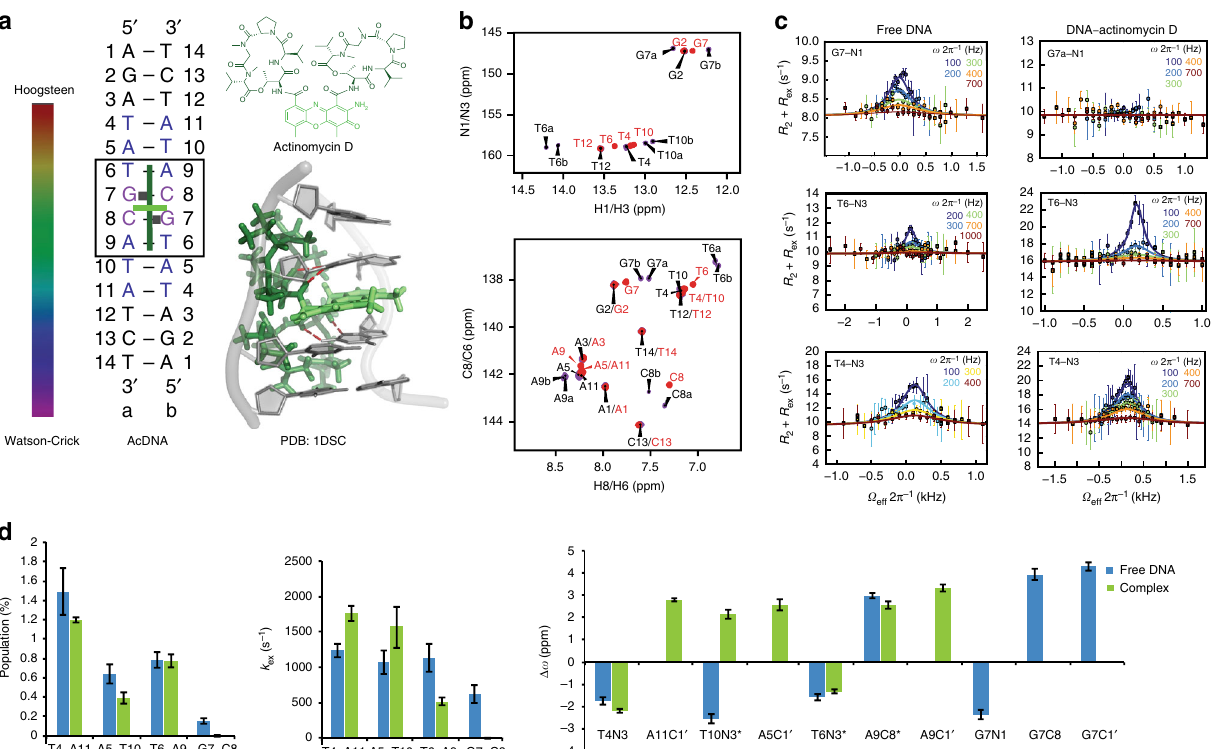
Fig. 5 Hoogsteen breathing in the DNA – actinomycin D complex. a Chemical structure of actinomycin D, crystal structure of the DNA – actinomycin D complex (PDBID 1DSC), and DNA construct used in NMR studies with color code showing Hoogsteen population (ranging between 0 to 100%). b Two- dimensional HSQC NMR spectra of DNA showing chemical shift perturbations on complex formation (red: free DNA; purple: complex). c Representative RD pro fi les measured in the free and bound duplex DNA showing modulation of Hoogsteen breathing on complex formation. Best fi ts to the Bloch – McConnell equations are shown. Error bars represent experimental uncertainty (one s.d.) derived using a Monte-Carlo method. d Comparison of exchange parameters measured in the free DNA and the DNA – actinomycin D complex. Sites with two sets of degenerate resonances are indicated with a “ * ” . RD data are shown for the “ a ” set of resonances noting that very similar results were obtained for the corresponding “ b ” set of resonances (Supplementary Table 1). Errors in all RD-derived fi tted parameters including population, k ex and Δ ω re fl ect experimental uncertainty (one s.d.) calculated by the Monte-Carlo approach from a single RD measurement containing more than 40 data points (see Methods). χ 2 < 1.5, P <